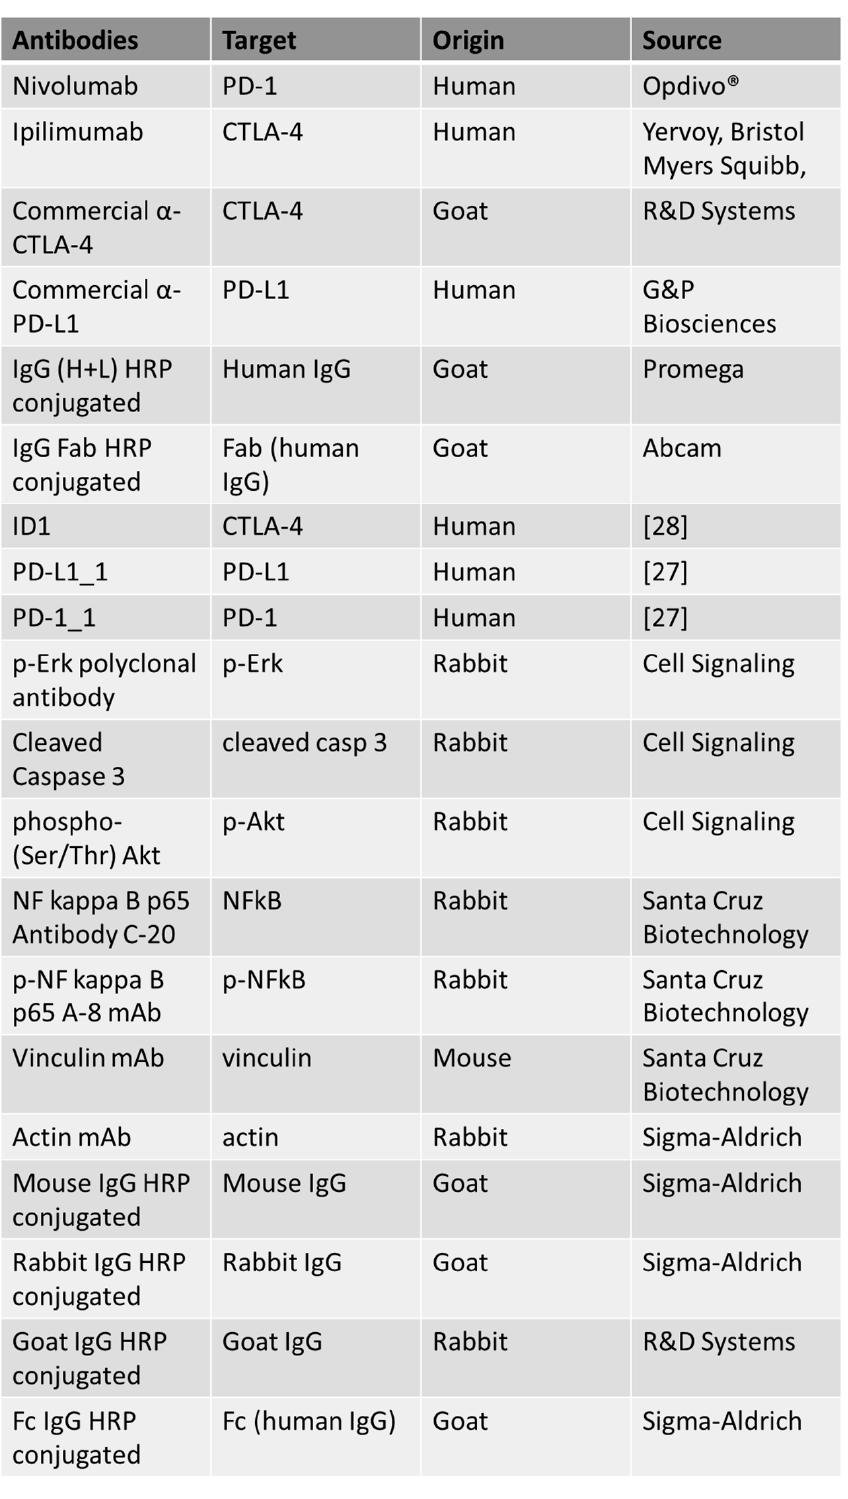
Figure 7. List of the antibodies used in this work. For each antibody used, the specific target, origin and source are indicated.